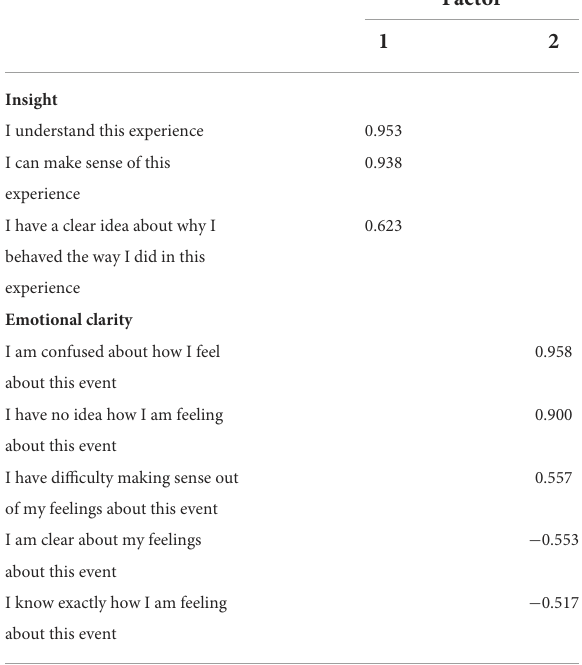
TABLE 1 Pattern matrix and factor loadings for insight and emotional clarity